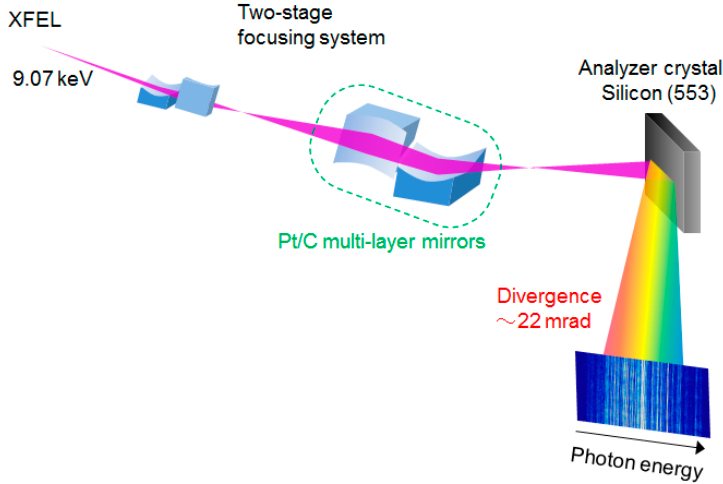
Figure 1. Experimental setup. The X-ray divergence was increased with the two-stage focusing optics, in which multi-layer elliptical mirrors were used as a second K-B optics. The spectral profile analyzed by a silicon (553) crystal is recorded with a MPCCD detector.